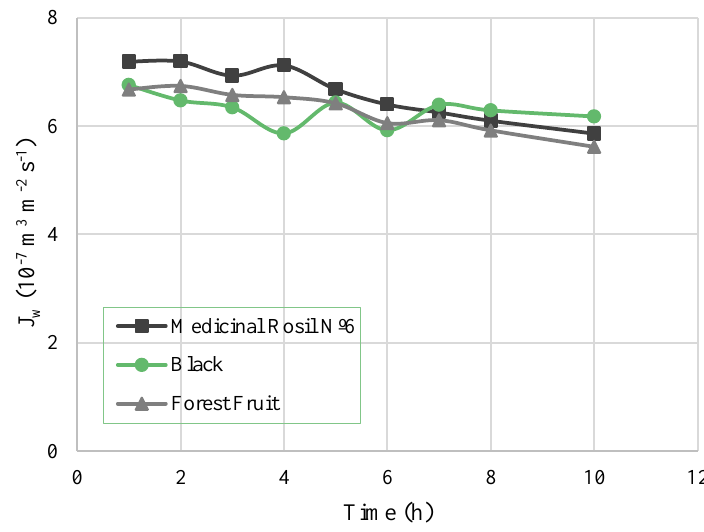
Figure 3. Water flux as a function of the time.